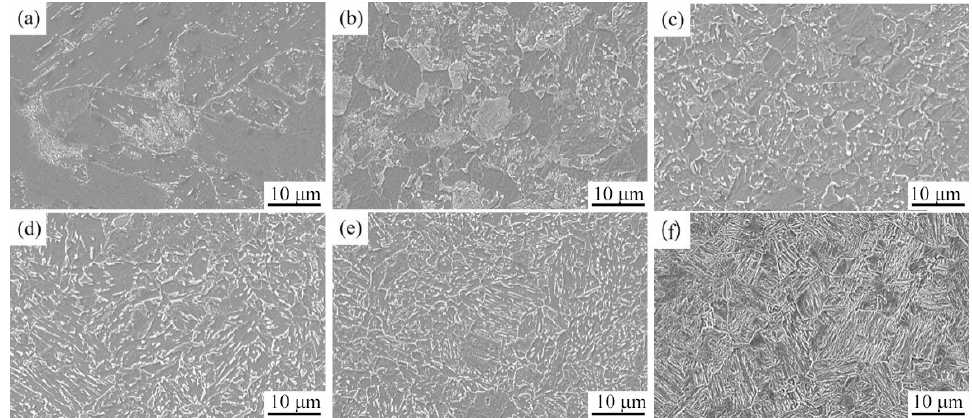
Figure 9. SEM morphology of the rolled specimens at different cooling rates ( a ) original microstruc- ture; ( b ) 0.05 °C·s − 1 ; ( c ) 0.1 °C·s − 1 ; ( d ) 2 °C·s − 1 ; ( e ) 10 °C·s − 1 ; ( f ) 50 °C·s − 1 . Therefore, it is inferred that the low temperature toughness and strength of the spec- imen with intercritical annealing is further enhanced.